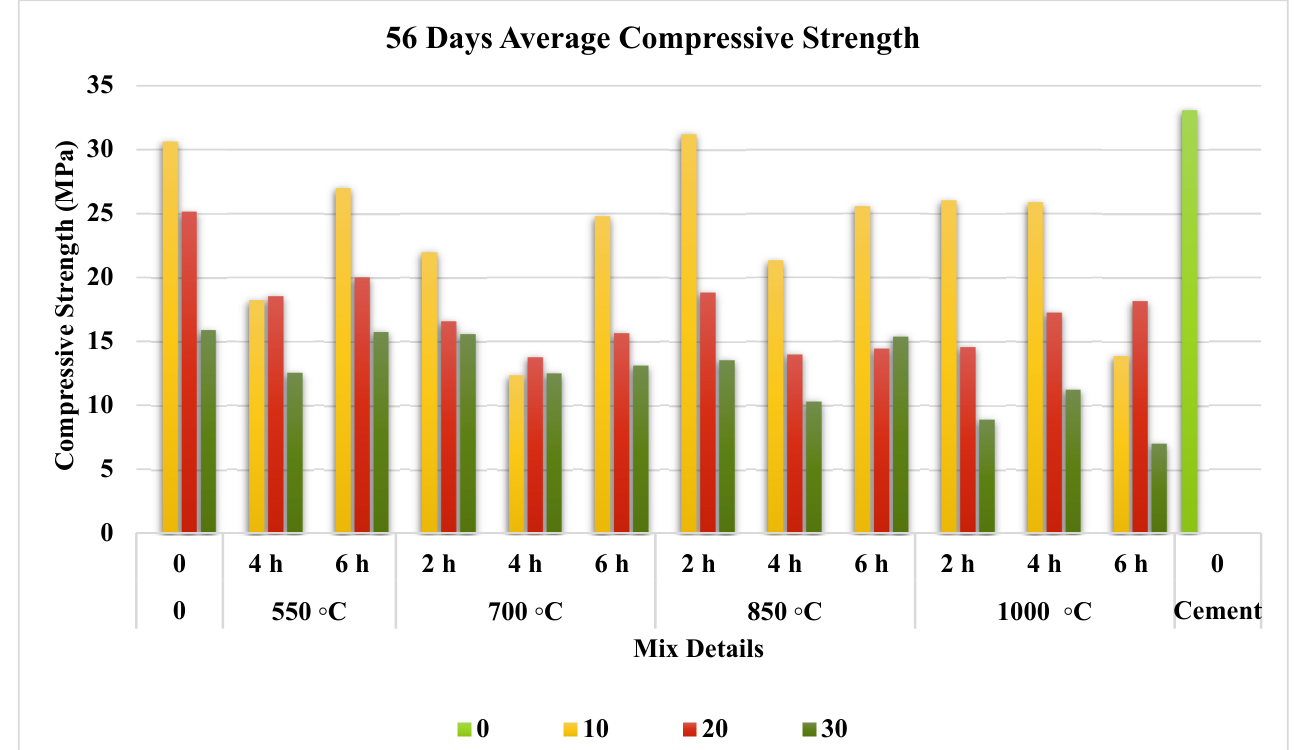
Figure 9. Effect of pre-treatment on 56 day compressive strength.